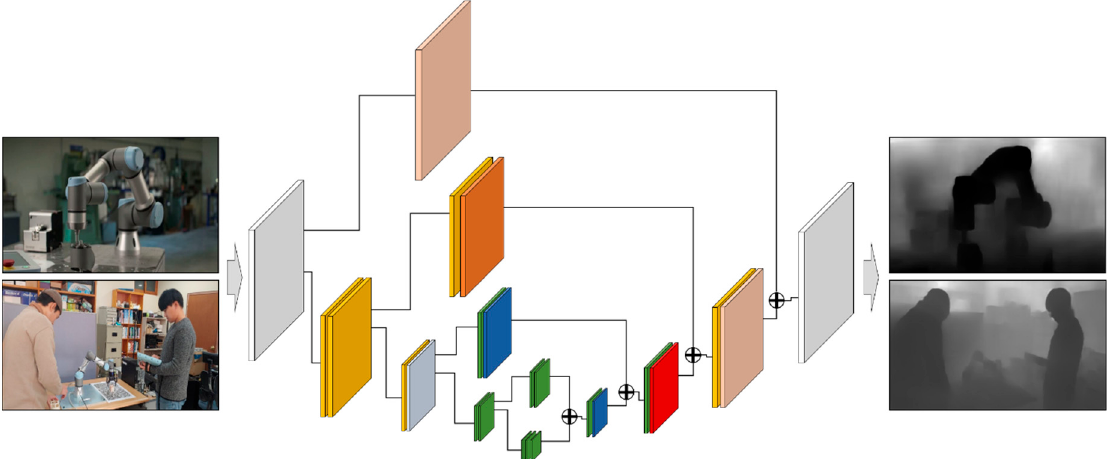
Figure 6. Depth prediction of object instances from the AR image for calculating 3D spatial relation.